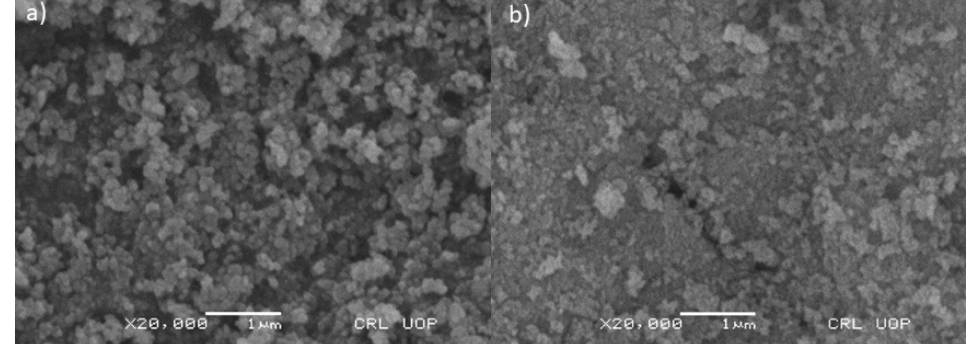
Figure 3. SEM micrographs of ( a ) Fe 3 O 4 and ( b ) Fe 3 O 4 @SiO 2